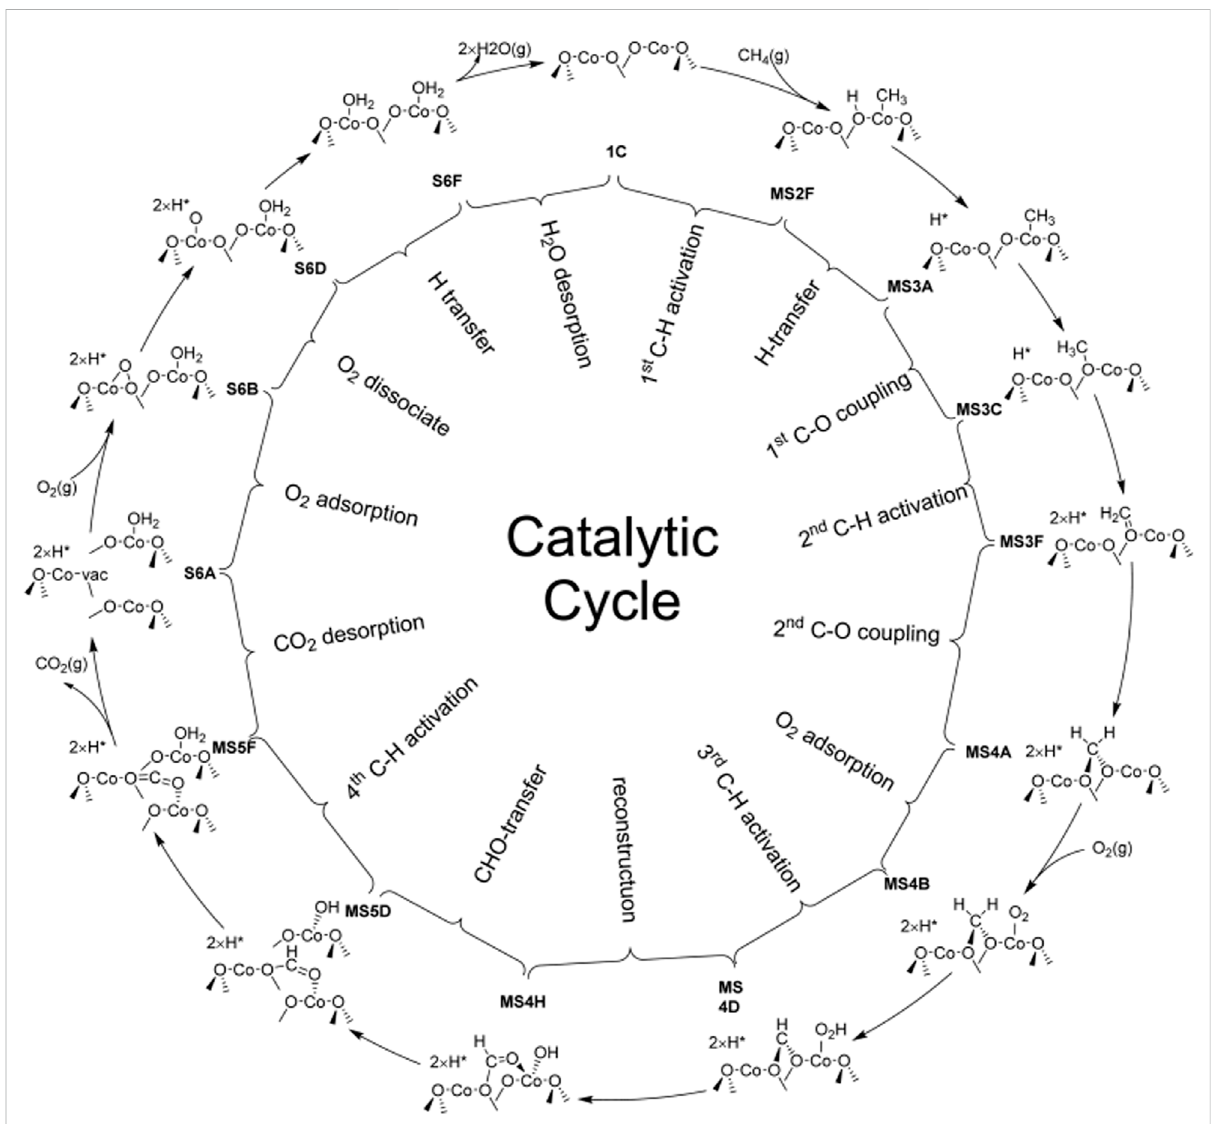
FIGURE 4 SchematicdiagramofthewholecatalyticcycleofCMCoverCo 3 O 4 (110)followingtheoptimalreactionmechanism.Reprintedwithpermission from Hu et al. (2016). Copyright (2016) American Chemical